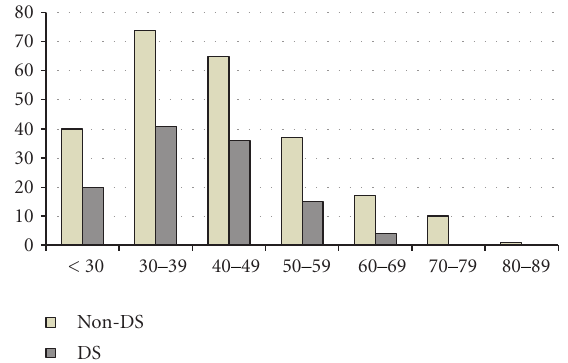
Figure 1: Age distribution of study participants at baseline ( N =